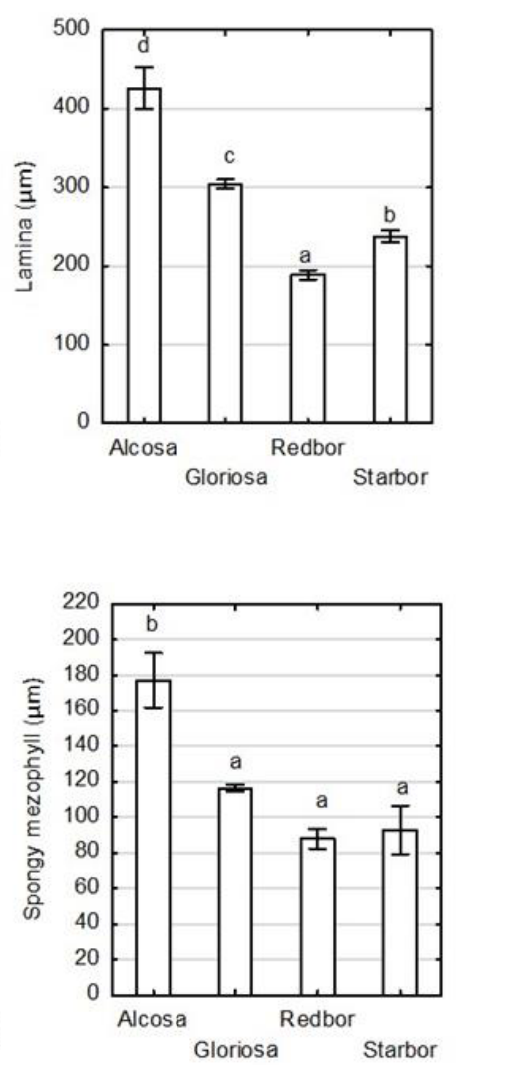
Figure 5. Anatomical characteristics (mean ± 1SE) of leaves of savoy cabbage and kale cultivars (one-way ANOVA followed by Newman-Keuls test: p < 0.05). Means with the same letter are not significantly different. ( a ) Thickness of lamina, ( b ) palisade mesophyll, ( c ) spongy mesophyll, and ( d ) abaxial epidermal layer.